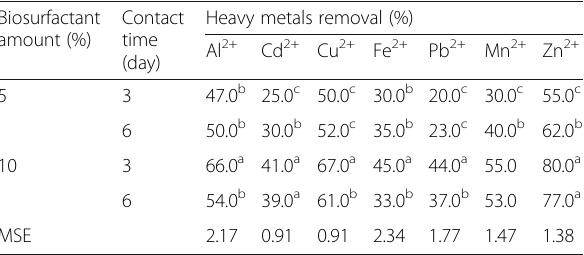
Table 4 Factors affecting removal of heavy metals from